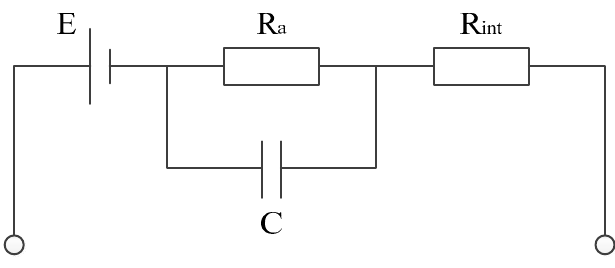
Figure 4. Fuel cell equivalent circuit model diagram.